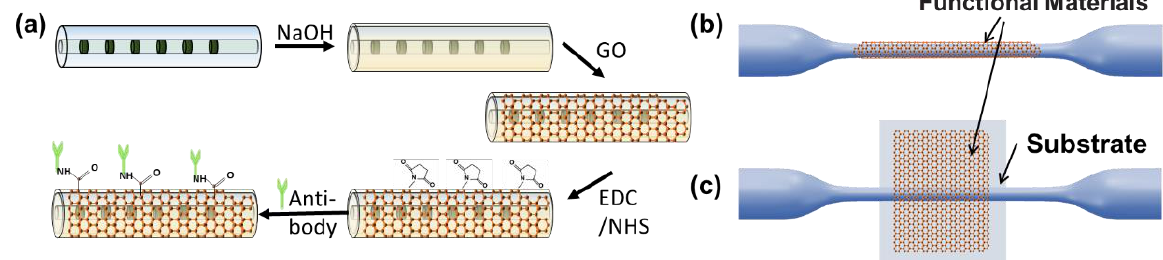
Figure 4. ( a ) Schematic illustration of the fabrication of a graphene oxide-coated LPG immunosensor. ( b , c ) Functional material integration into the optical fiber waveguide platform.